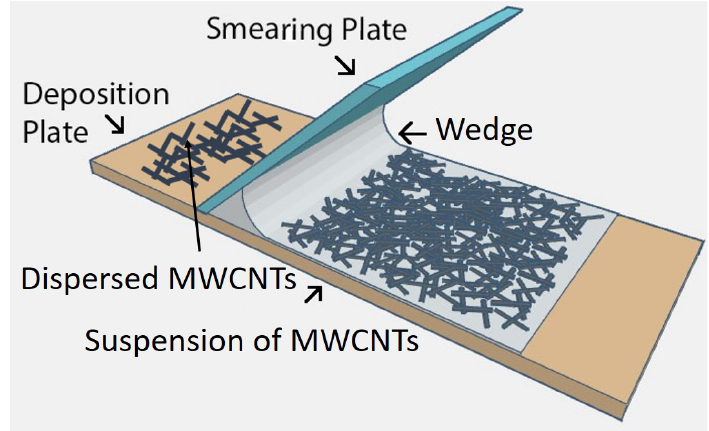
Figure 1. Schematic illustration of the meniscus-dragging deposition (MDD) method for fabricating MWCNT networks